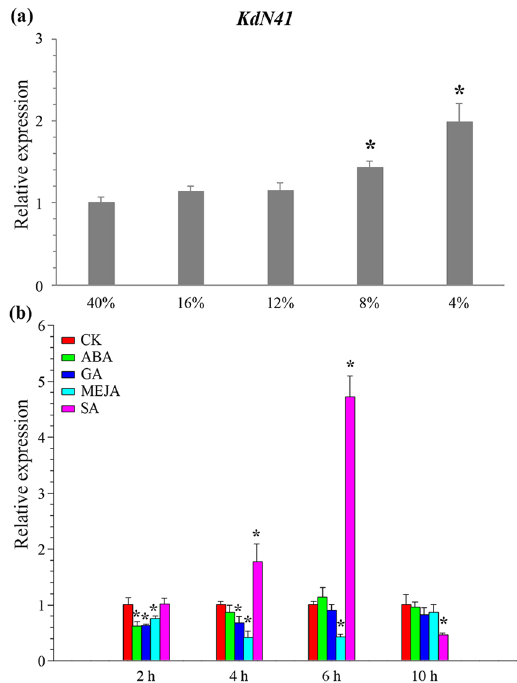
Figure 1. KdN41 expression patterns in response to drought and different hormone treatments. ( a ) KdN41 expression patterns in response to increasing drought stress. The horizontal axis represents relative soil water content, the water content of 40% is CK; ( b ) KdN41 expression patterns in response to different hormone treatments. Abscisic acid (ABA), salicylic acid (SA) gibberellins (GA), methyl jasmonate (MeJa), and H 2 O (CK). * Indicated a significant difference when compared with CK ( p < 0.05); Errors bars represented ± SD (standard deviations) of nine independent replications. The expression level of CK at 2 h was treated as reference and calculated as